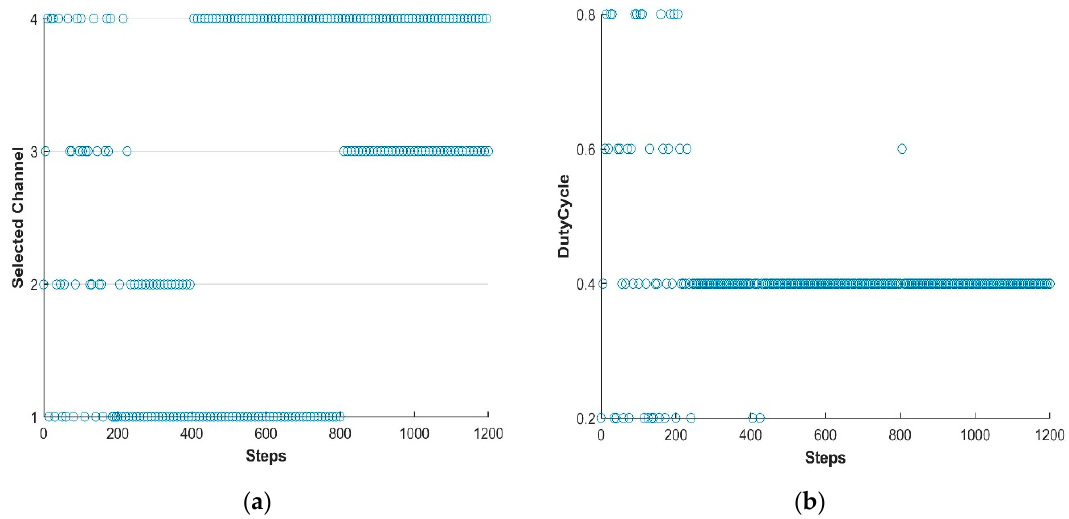
Figure 6. LTE-U BS with COT method. ( a ) Channel selection vs number of steps; ( b ) Dutycycle selection vs number of steps.